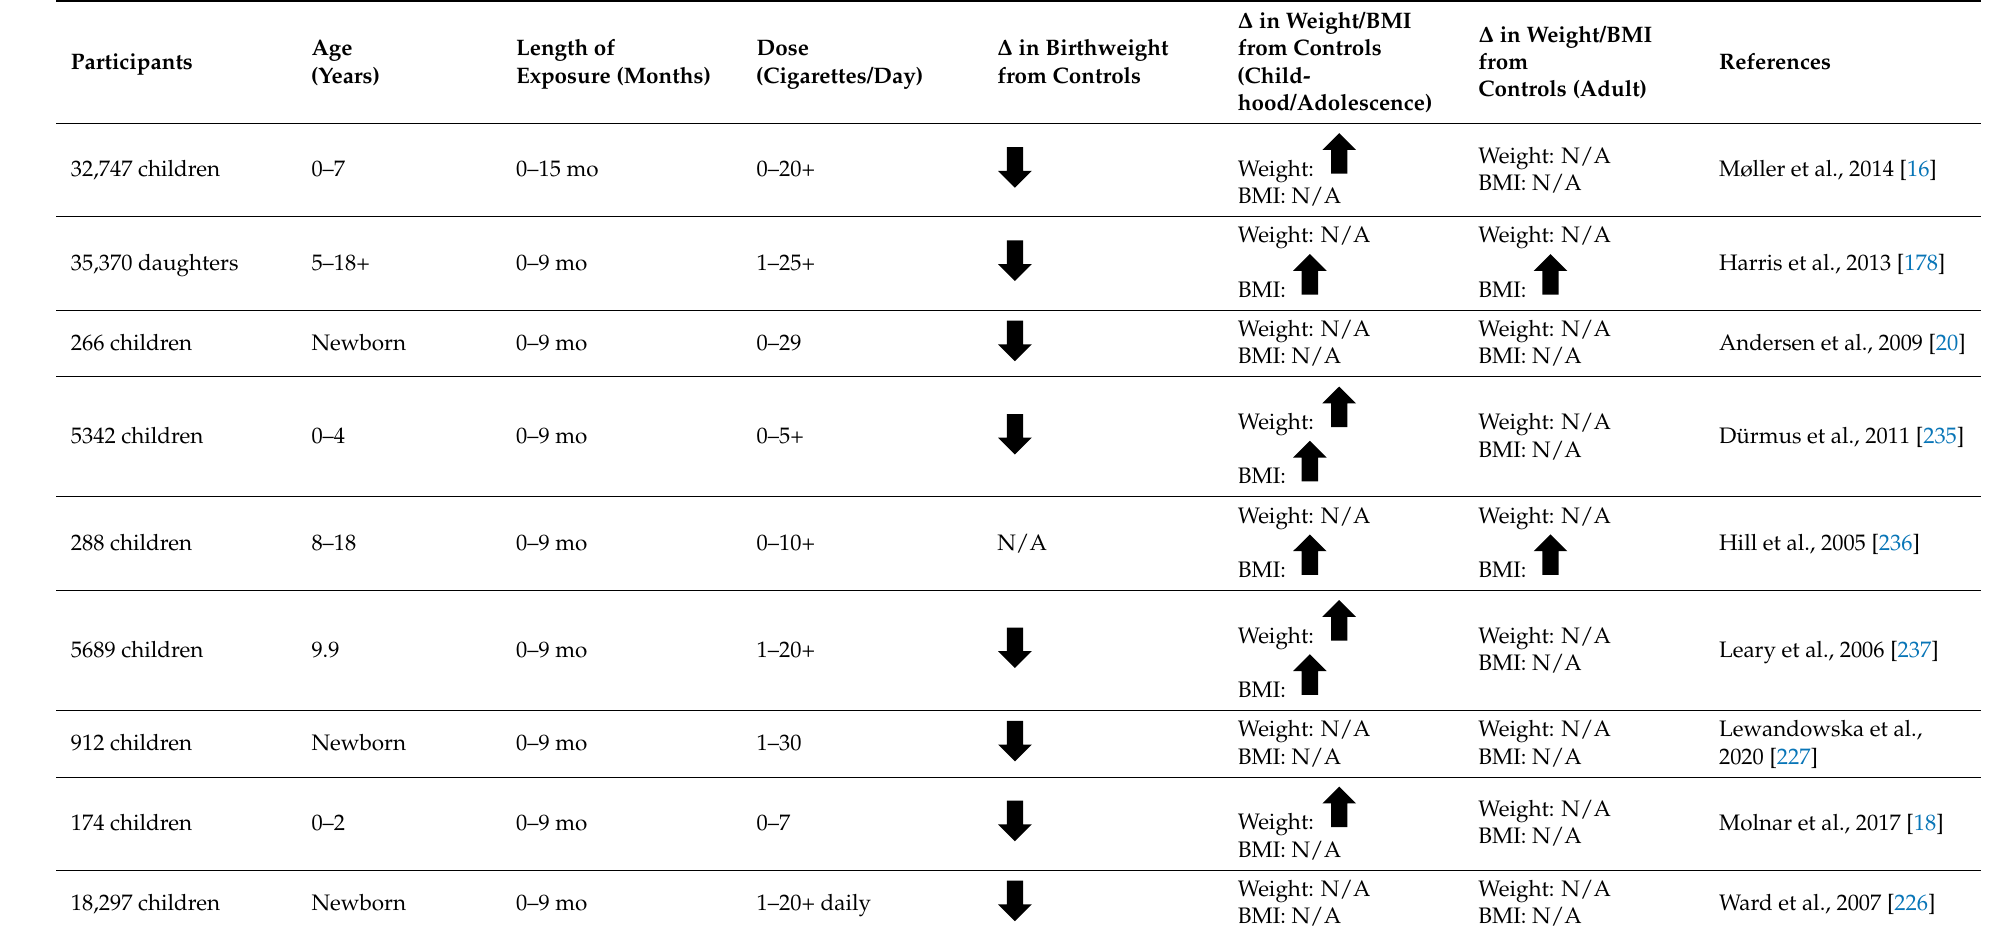
Table 2. Prenatal Nicotine Effects on Body Weight in Rodents.